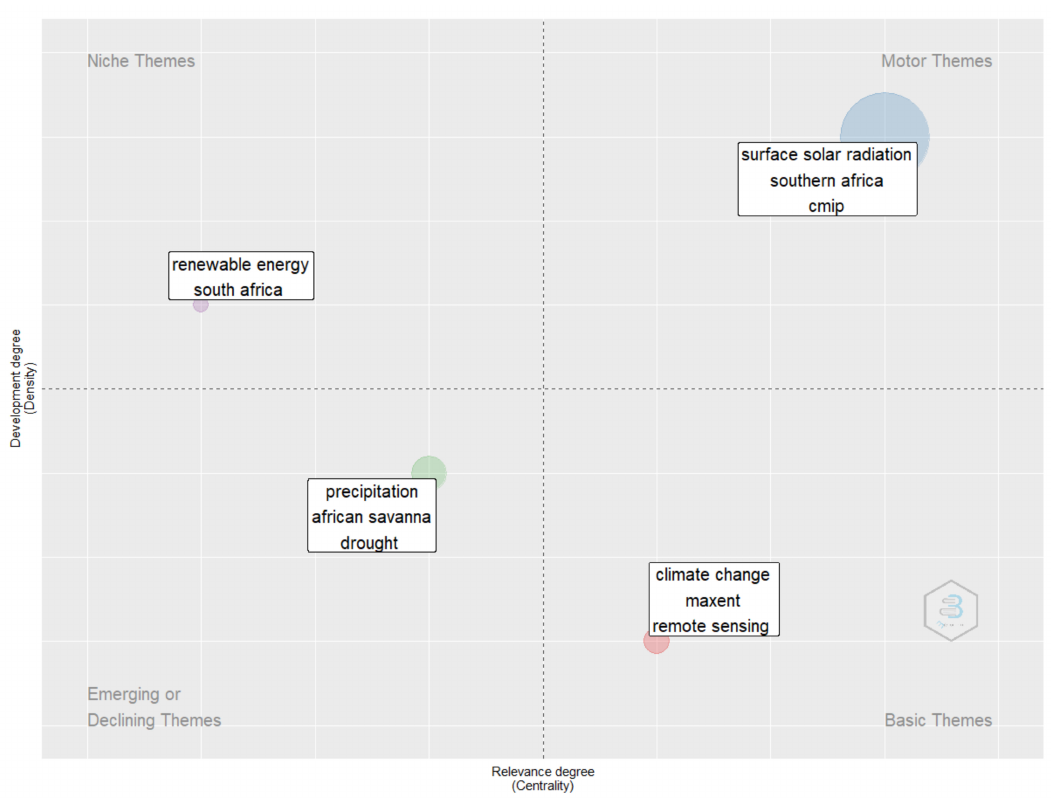
Figure 8. A thematic network of themes from southern African